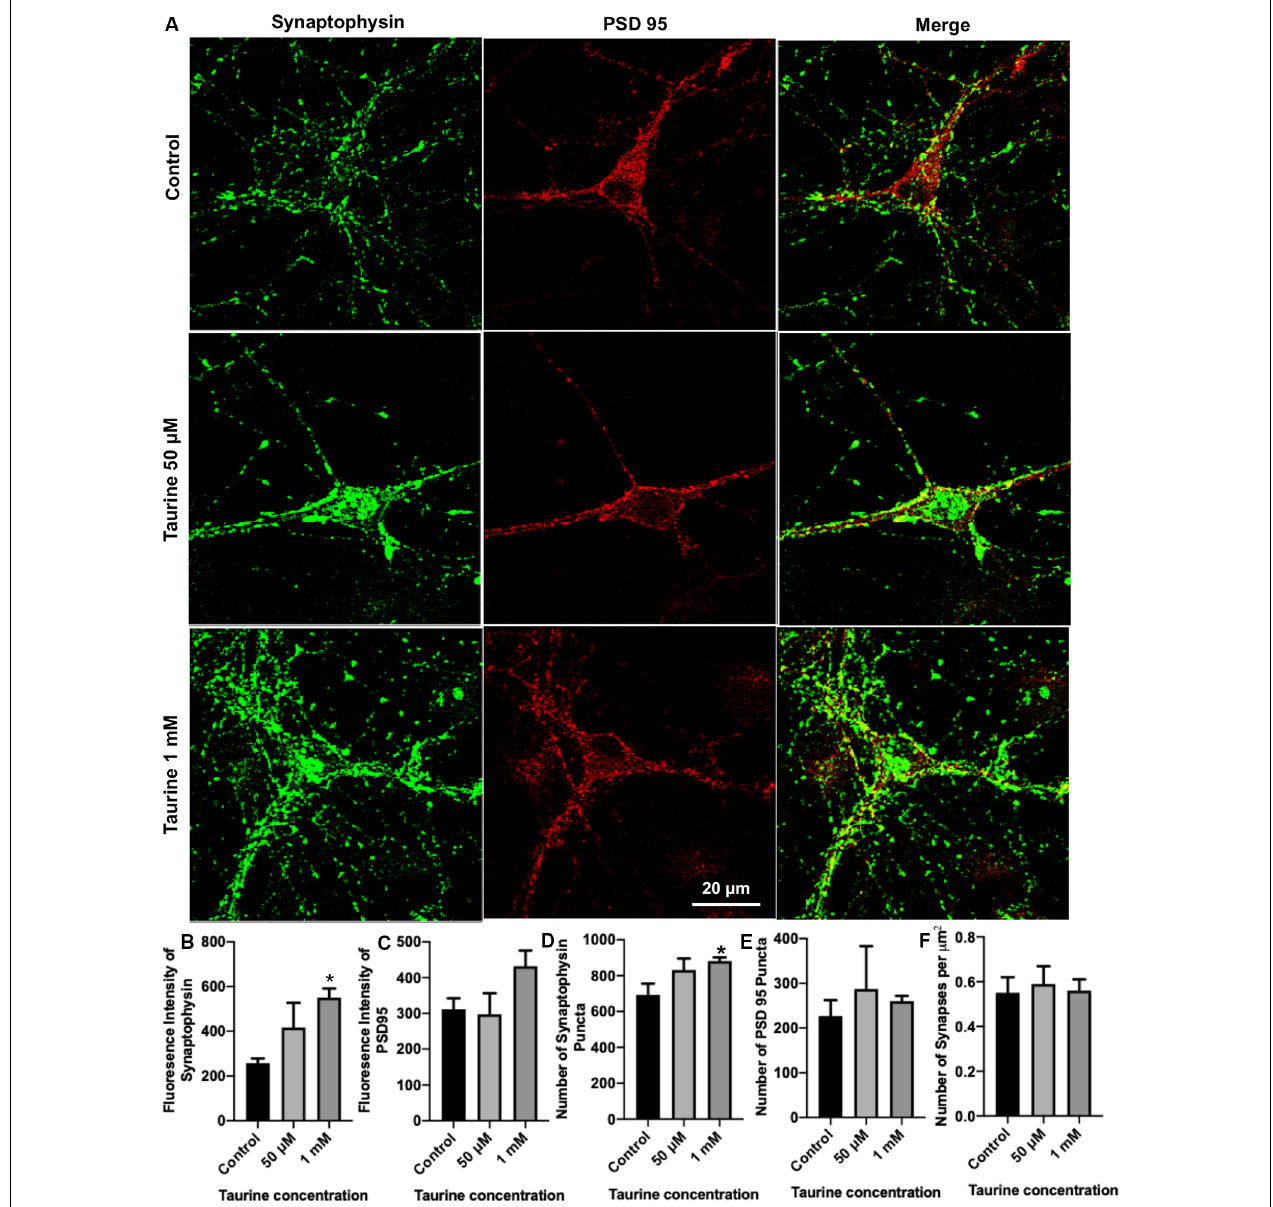
FIGURE 3 | Taurine enhances the expression of presynaptic protein and presynaptic puncta in rat cortical neurons. Cortical neurons were cultured with 50 µ M taurine, 1 mM taurine, or without taurine (control) for 10 days to allow for the development of mature networks. On day 10, cells were fixed and stained with antibodies against the presynaptic vesicle protein synaptophysin and the postsynaptic receptor density protein PSD95. Images were acquired using confocal microscopy and whole networks (entire fluorescent images) were analyzed for synaptic protein intensity, puncta, and colocalization. (A) Representative immunofluorescent images show the staining of synaptic proteins of control, 50 µ M, 1 mM taurine-treated cortical neurons. (B,C) The addition of 1 mM taurine to culture media significantly increased the intensity of synaptophysin expression while not significantly altering PSD95 intensity. Specifically, the fluorescent intensity of synaptophysin in control was 257.6 ± 20.7, in taurine at 50 µ M was 417.3 ± 110, and in taurine at 1 mM was 551.1 ± 39.6 ( p = 0.02 for control vs. 1 mM taurine). The fluorescence intensity of PSD95 in control was 311.9 ± 30.5, in taurine at 50 µ M was 297.1 ± 59.5, and in taurine at 1 mM was 431.9 ± 44.3 ( p = 0.108). (D,E) The number of presynaptic synaptophysin and postsynaptic PSD95 puncta in a fluorescent image was measured by the ImageJ plugin SynQuant. The only significant change in puncta number occurred after 1 mM taurine treatment for synaptophysin puncta. Specifically, the number of synaptophysin puncta in control was 692.8 ± 63.3, in taurine at 50 µ M was 832.3 ± 63.3, and in taurine at 1 mM was 881.7 ± 20.7 ( p = 0.03 for control vs. 1 mM taurine). The number of PSD95 puncta in control was 226.8 ± 35.3, in taurine at 50 uM was 287.5 ± 95.6, and in taurine at 1 mM was 260.2 ± 11.8 ( p = 0.743). (F) SynapCountJ, an ImageJ plugin, was utilized to determine synapses (per µ m 2 ) via colocalization of synaptophysin and PSD95 in traced neurites. There was no significant difference in the number of synapses between any treatments. Control cell number of synapses (per µ m 2 ) was 0.55 ± 0.07, 50 µ M taurine was 0.59 ± 0.08, and 1 mM taurine was 0.56 ± 0.05 ( p = 0.904; n = 4 images for control and 50 µ M taurine-treated neurons; n = 6 images for 1 mM taurine-treated neurons; the statistical test was one-way ANOVA in all cases). *Indicates a significance level of p < 0.05 vs. control.